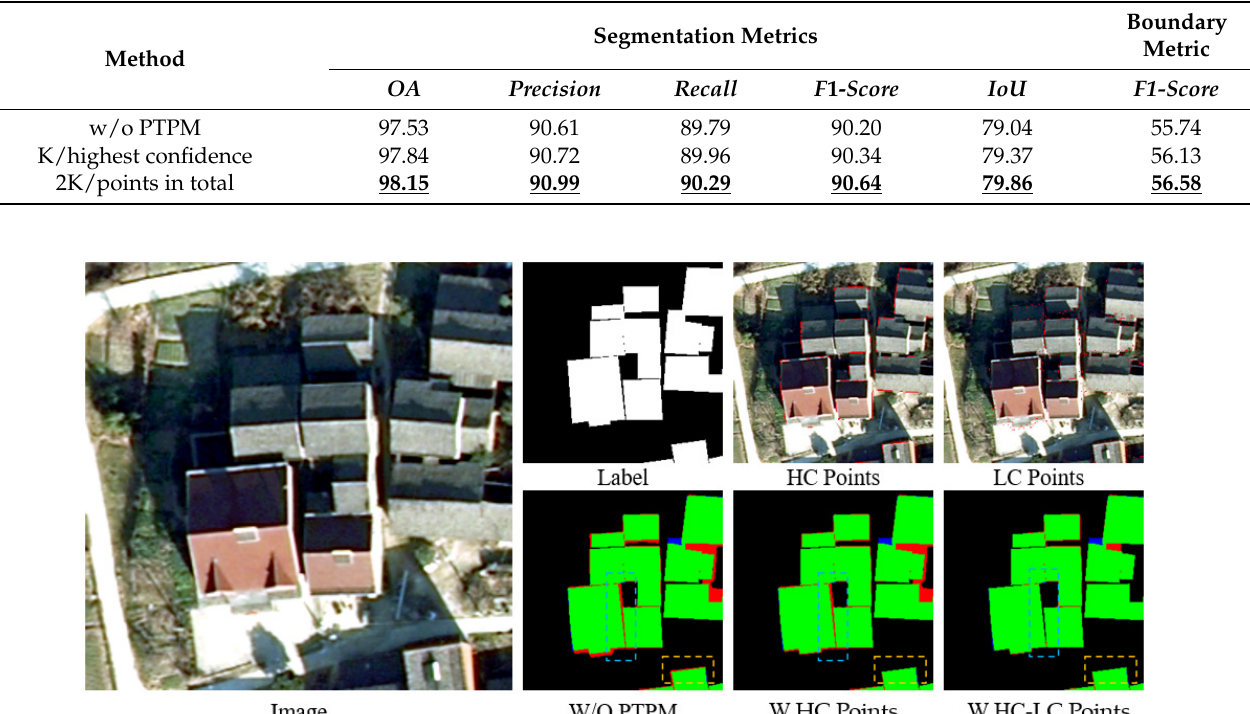
Table 6. Quantitative evaluation (%) of MBNet with and without different point-to-point module kinds. The best metric value is highlighted in bold and underlined.